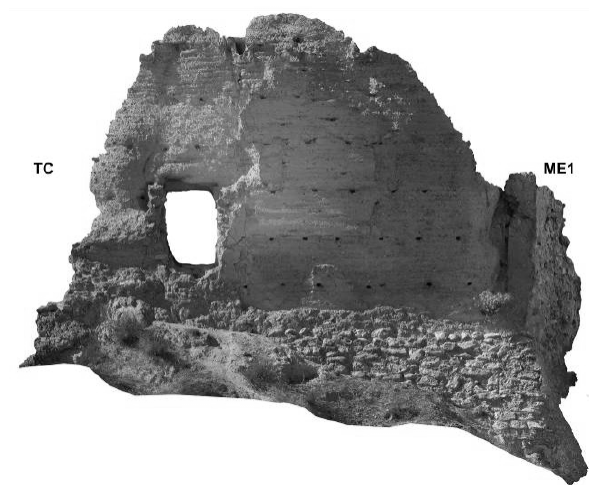
Figure 11. Tower A. Eastern front. Orthomosaic.